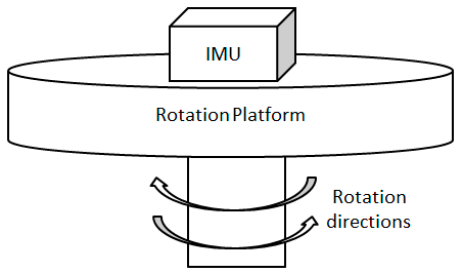
Figure 1. Structure of rotary inertial navigation system (INS).